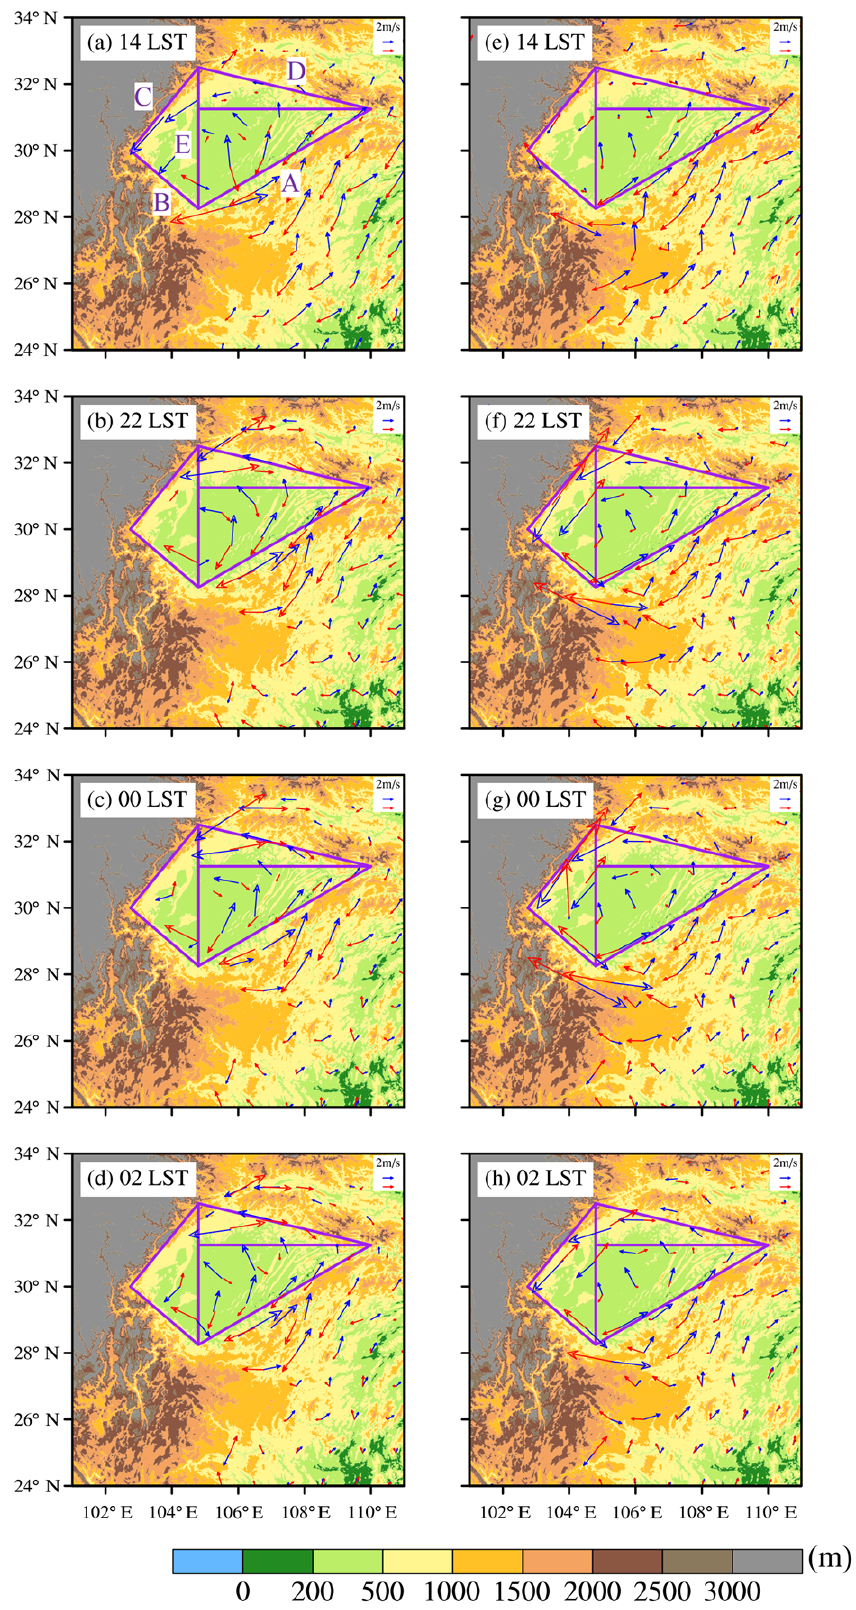
Figure 10. Diurnal variations of geostrophic circumfluence flows (blue arrows) and ageostrophic circumfluence flows (red arrows). ( a – d ) 900 hPa, ( e – h ) 850 hPa. Purple lines in ( a ) represent boundaries A, B, C, D, and E.